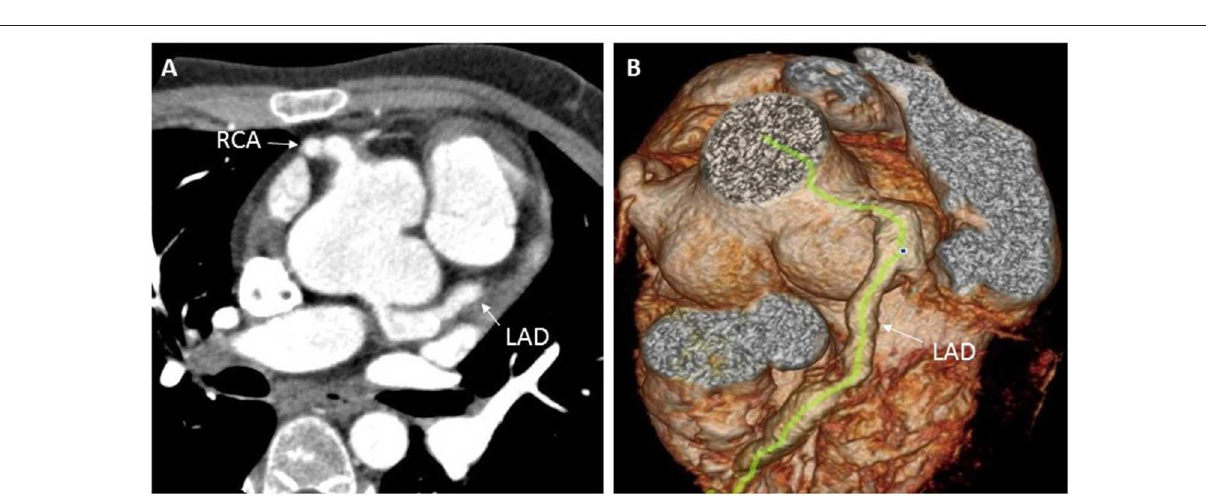
FIGURE 3 | Enhanced coronary CT examination showing left and right coronary artery aneurysms (A) , and three-dimensional CT reconstruction of the aorta showing dilation of the aortic root and the left anterior descending coronary artery (B) . CT, computed tomography; LAD, left anterior descending; RCA, right coronary